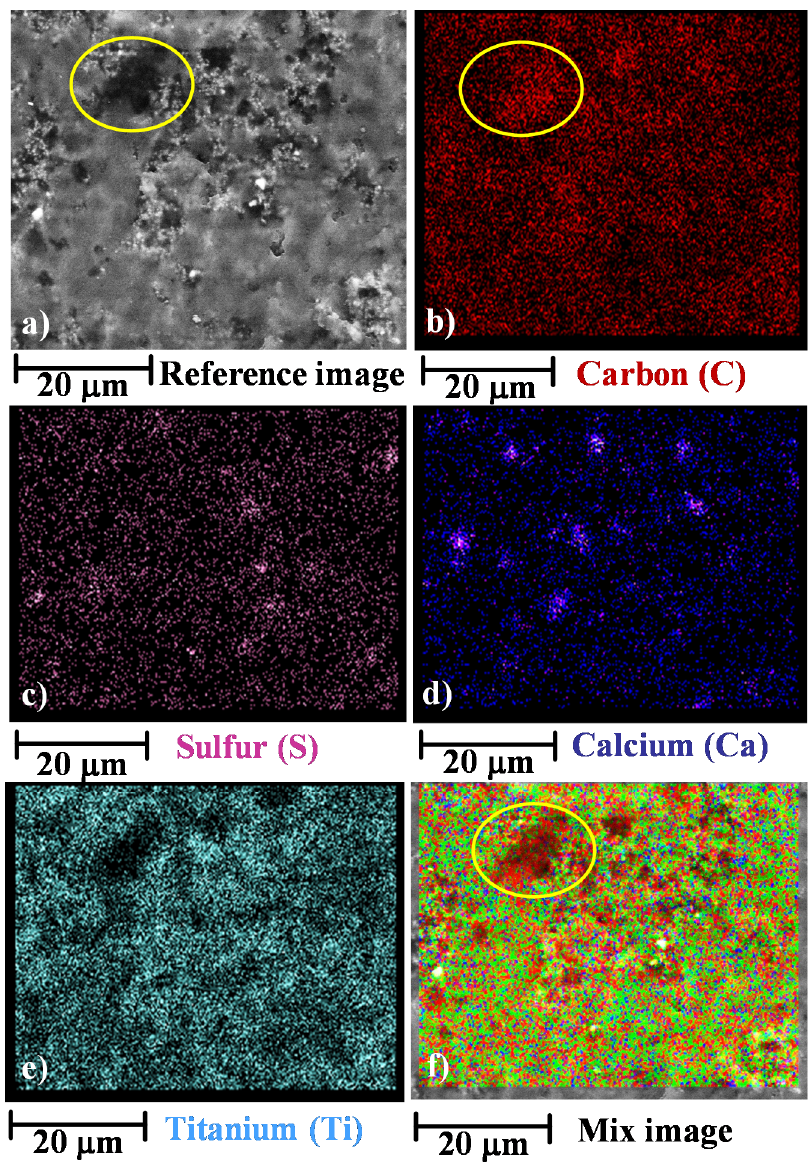
Figure 2. Energy dispersive X-ray (EDX) performed on the fracture surface of the sample 01GNPs: ( a ) reference image; ( b ) map distribution of C; ( c ) map distribution of S; ( d ) map distribution of Ca; ( e ) map distribution of Ti; ( f ) mix image.